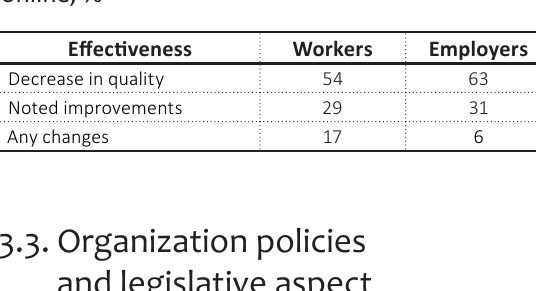
Table 6. Assessment of effectiveness of working online, %